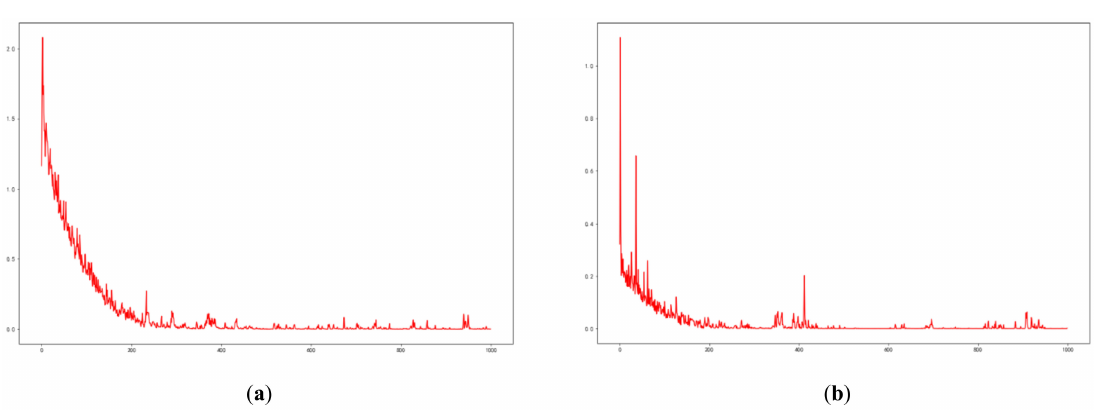
Figure 8. Loss of time-reversal signal classification during neural network training: ( a ) WideResnet40_2 octonary classifica- tion, ( b ) WideResnet40_2 binary classification, ( c ) Densenet121 octonary classification, ( d ) Densenet121 binary classification, ( e ) LSTM octonary classification, and ( f ) LSTM binary classification. The signals measured directly were also input into the neural network with the same hyper-parameters. The loss function value changed as the number of iterations increased during the training process, as shown in Figure